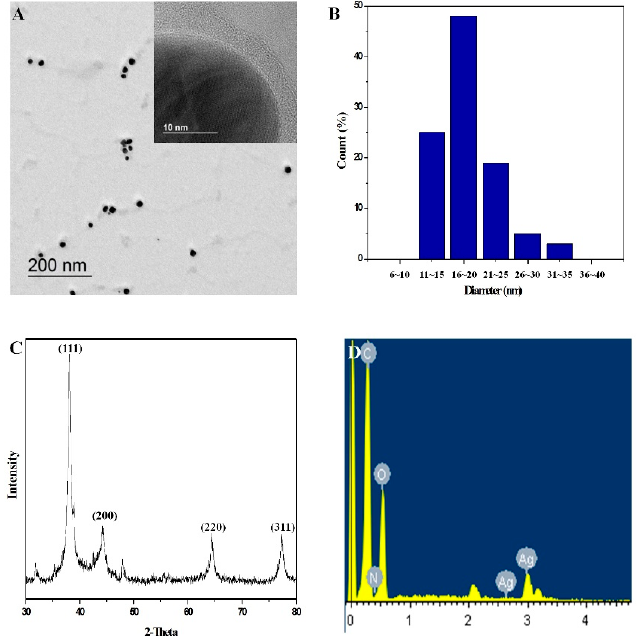
Figure 1. ( A ) HRTEM images; ( B ) the size distribution; ( C ) XRD patterns; and ( D ) EDS spectrum of polyDOPA-AgNPs.